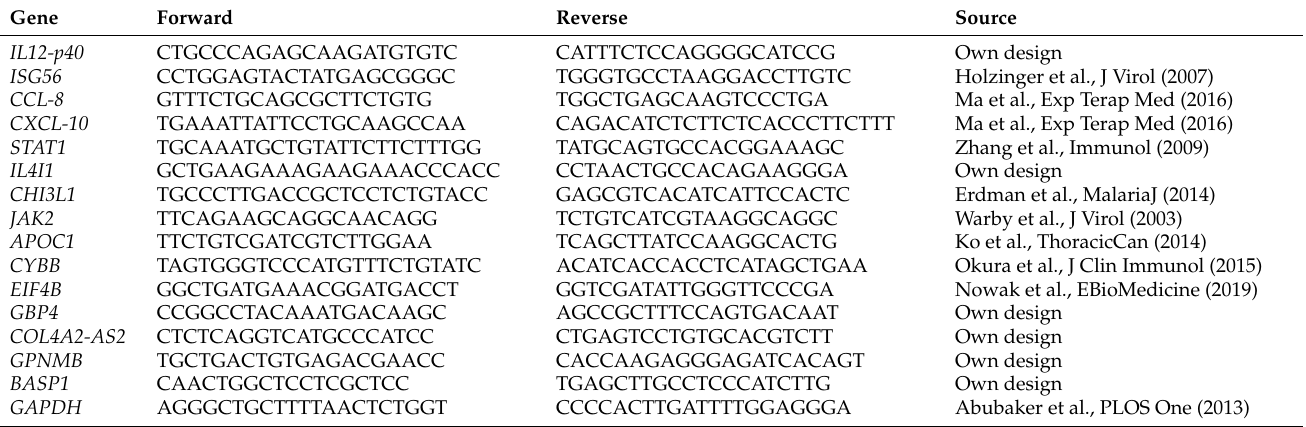
Table A1. Primer list for the genes assessed through RT-qPCR.